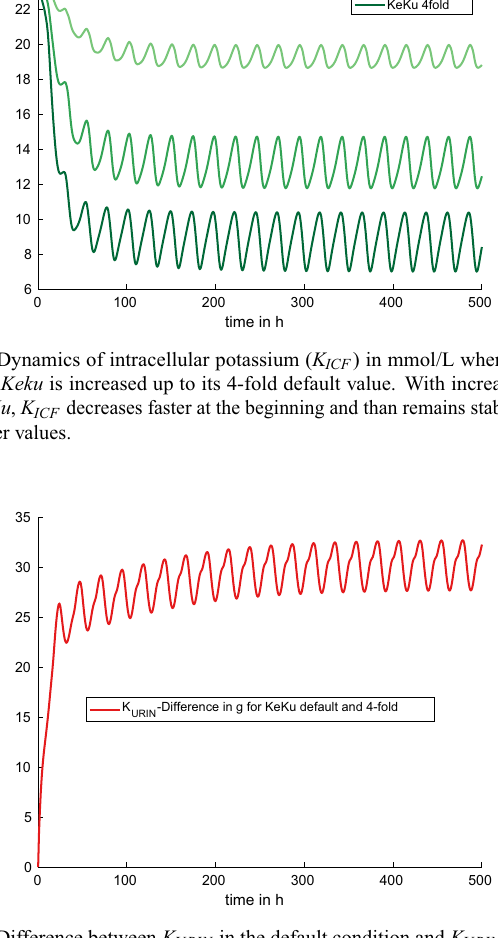
(c) Dynamics of extracellular potassium ( K ECF ) in mmol/L when the (d) Difference between K URIN in the default condition and K URIN at a rate Keku is increased up to its 4-fold default value. With increasing 4-fold increased rate KeKu (in gram). KeKu , K ECF decreases faster at the beginning and than remains stable at lower values. Figure 4. Experiment 3: increased potassium excretion with urine by increasing the rate KeKu up to the fourfold of its default